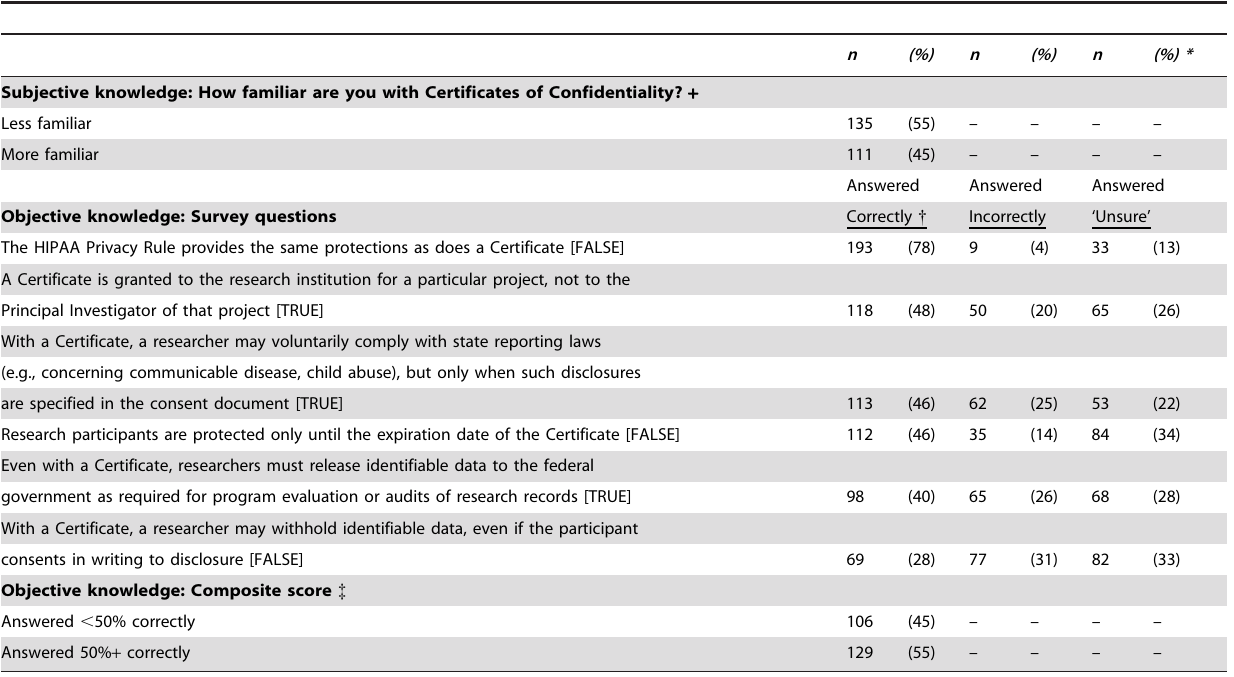
Table 2. Familiarity with Certificates of Confidentiality (n